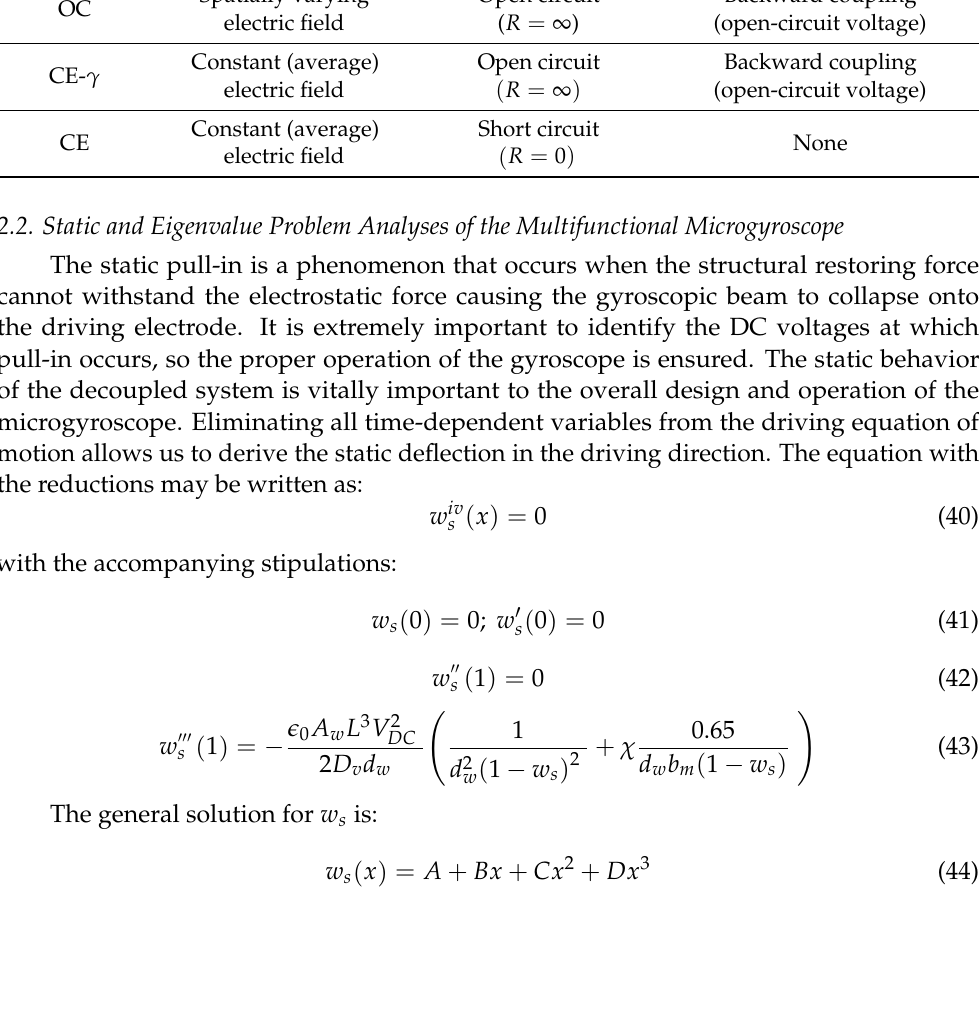
Voltage Coupling in Sensing E.O.M Backward coupling (resistance-dependent voltage